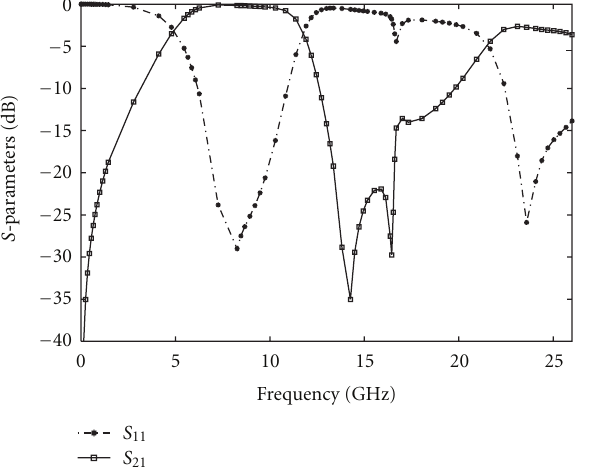
Figure 5: Scattering parameters for the DS-UC by FIT. s 1 = s 2 = 0 . 22 mm; g 1 = g 2 = 0 . 1mm, Δ = 0 . 1 mm, w 1 = 0 . 9mm, w 2 = 1 . 34 mm; l 1 = l 2 = 0 . 45 mm, l = 7 . 24 mm, h = 0 . 635 mm, ε r